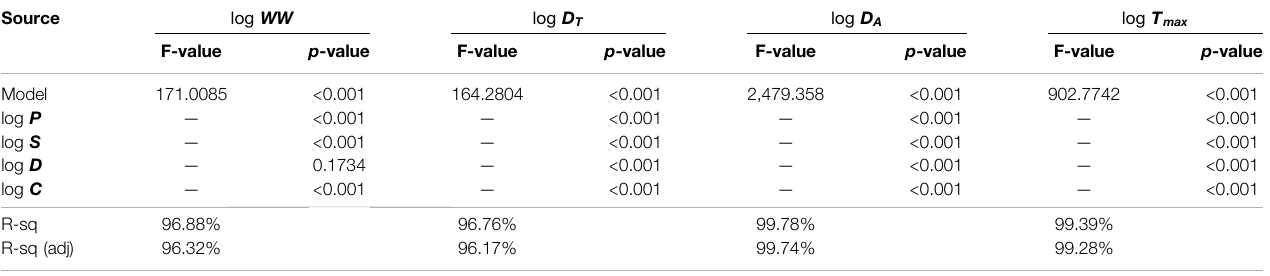
TABLE 4 | ANOVA results forlog WW , log D T , log D A and log T max .